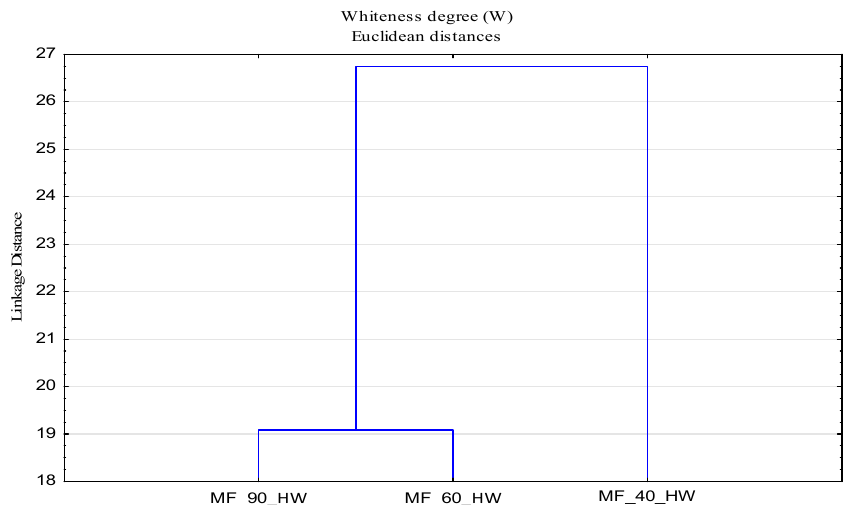
Figure 10. Dendrogram of the whiteness degree (W) of surface modified fabrics as a function of temperature (T) and hard water (HW).